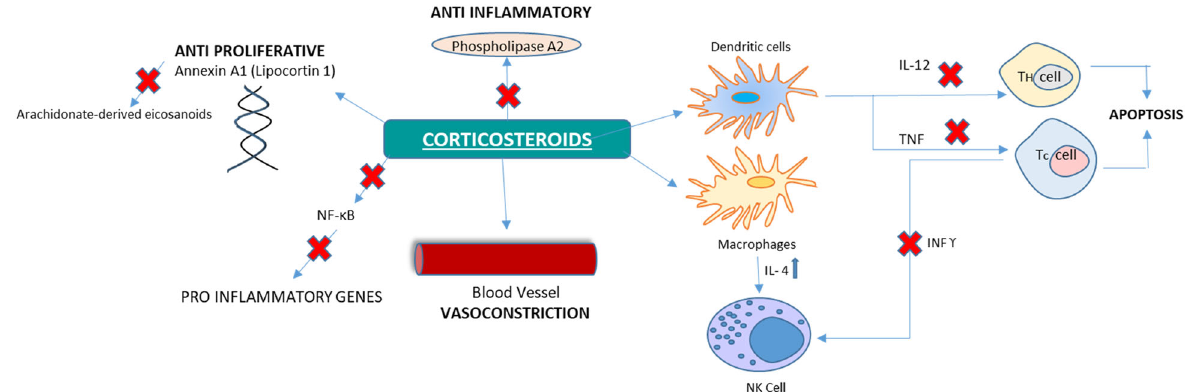
Fig. 1 Mechanism of action of